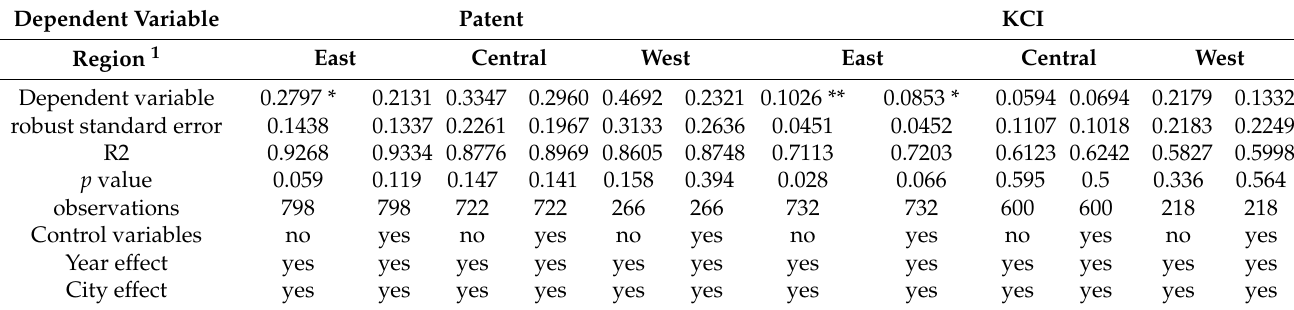
Table 5. The effects of HIDZs on cities in various regions in China.